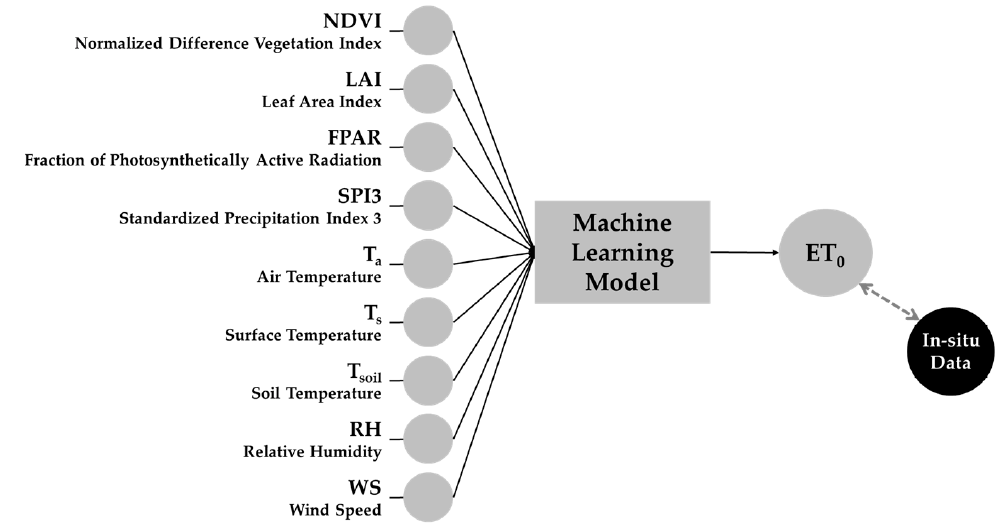
Figure 1. Input variables for the machine learning (ML) model to retrieve the gridded reference evapotranspiration (ET 0 ) in the croplands of South Korea, with the in situ point data from Korea Meteorology Administration (KMA).